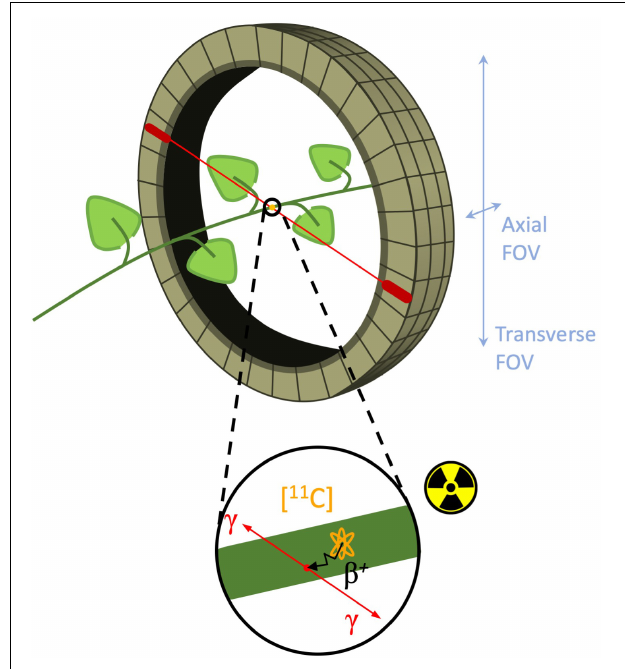
FIGURE 1 | Schematic of branch inside a PET detector ring, i.e., field of view (FOV). Positron decay of the (orange) 11 C-nucleus in the branch is shown in the enlarged circle. The positron is traveling a certain distance (typically 1.2 mm for 11 C-positrons - black arrow) known as the positron range to eventually collide with an electron and annihilate to produce two γ -photons (red arrows) traveling in opposite (180 ◦ ) direction. Subsequently, these γ -photons can be detected by two different PET detectors (red ovals) in the detector